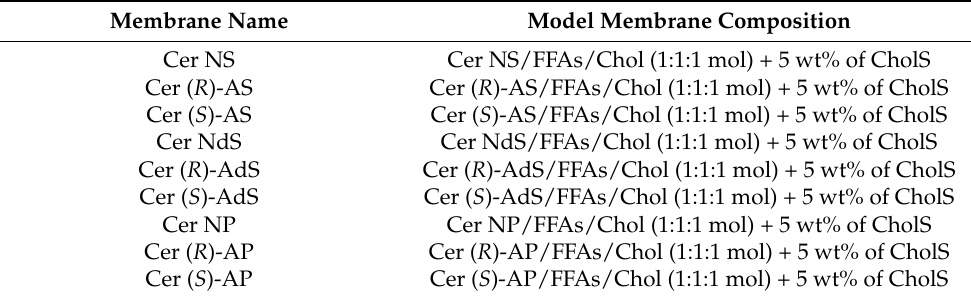
Figure 1. Structures of the α -hydroxylated Cers with physiological (i.e ., Cer ( R )-AS, Cer ( R )-AdS, and Cer ( R )-AP) and unnatural stereochemistry (i.e ., Cer ( S )-AS, Cer ( S )-AdS, and Cer ( S )-AP) and their non-hydroxylated counterparts (i.e ., Cer NS, Cer NdS, and Cer NP) investigated in this work. Table 1. The composition of model membranes used in this